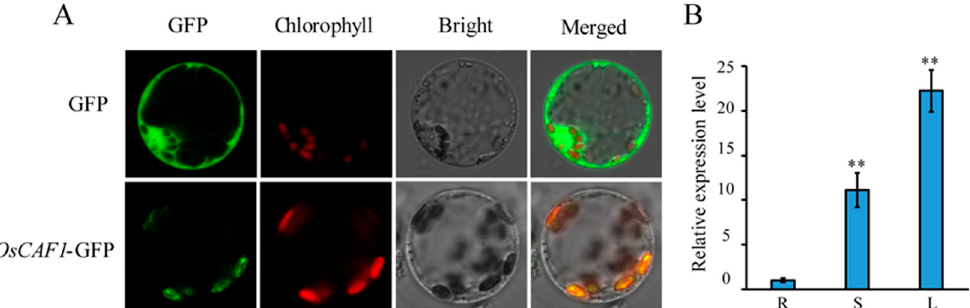
Figure 6. Subcellular localization and expression patterns of OsCAF1. ( A ) Subcellular localization of OsCAF1 in rice protoplasts. ( B ) Expression analysis of OsCAF1 in different tissues. The tissues include roots (R), stems (S), and leaves (L). The values in the figures represent the means ± SE ( n = 3). ** indicate p < 0.01.